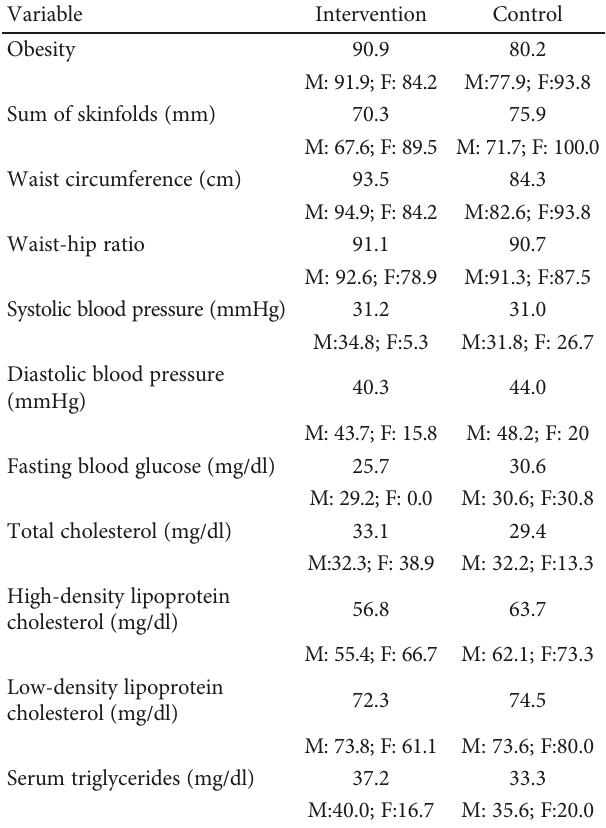
Table 2: Prevalence (%) of high/abnormal values of risk factors ∗ at